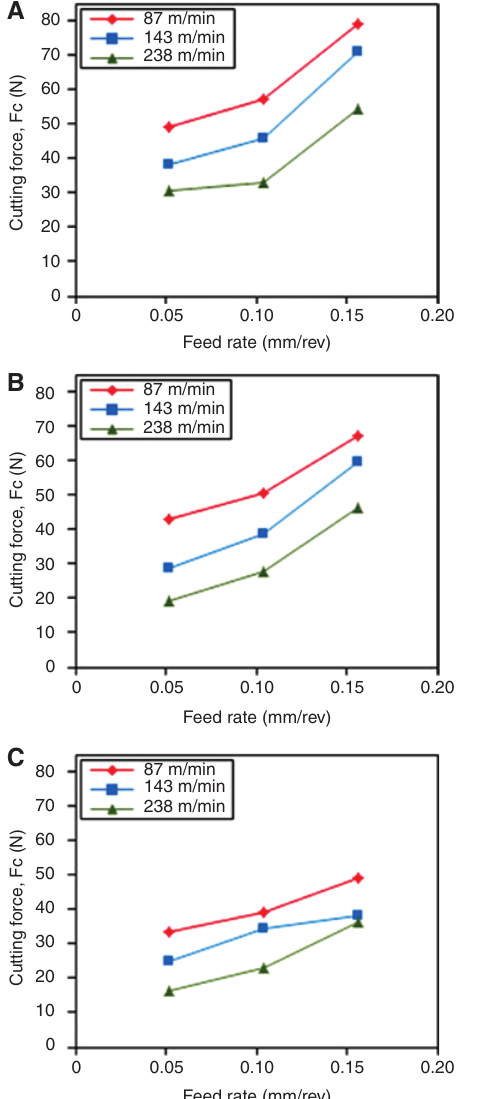
Figure 6 Effect of feed rate on cutting force for various tool radi- uses: (A) r = 0.4 mm, (B) r = 0.8 mm, and (C) r = 1.2 mm.